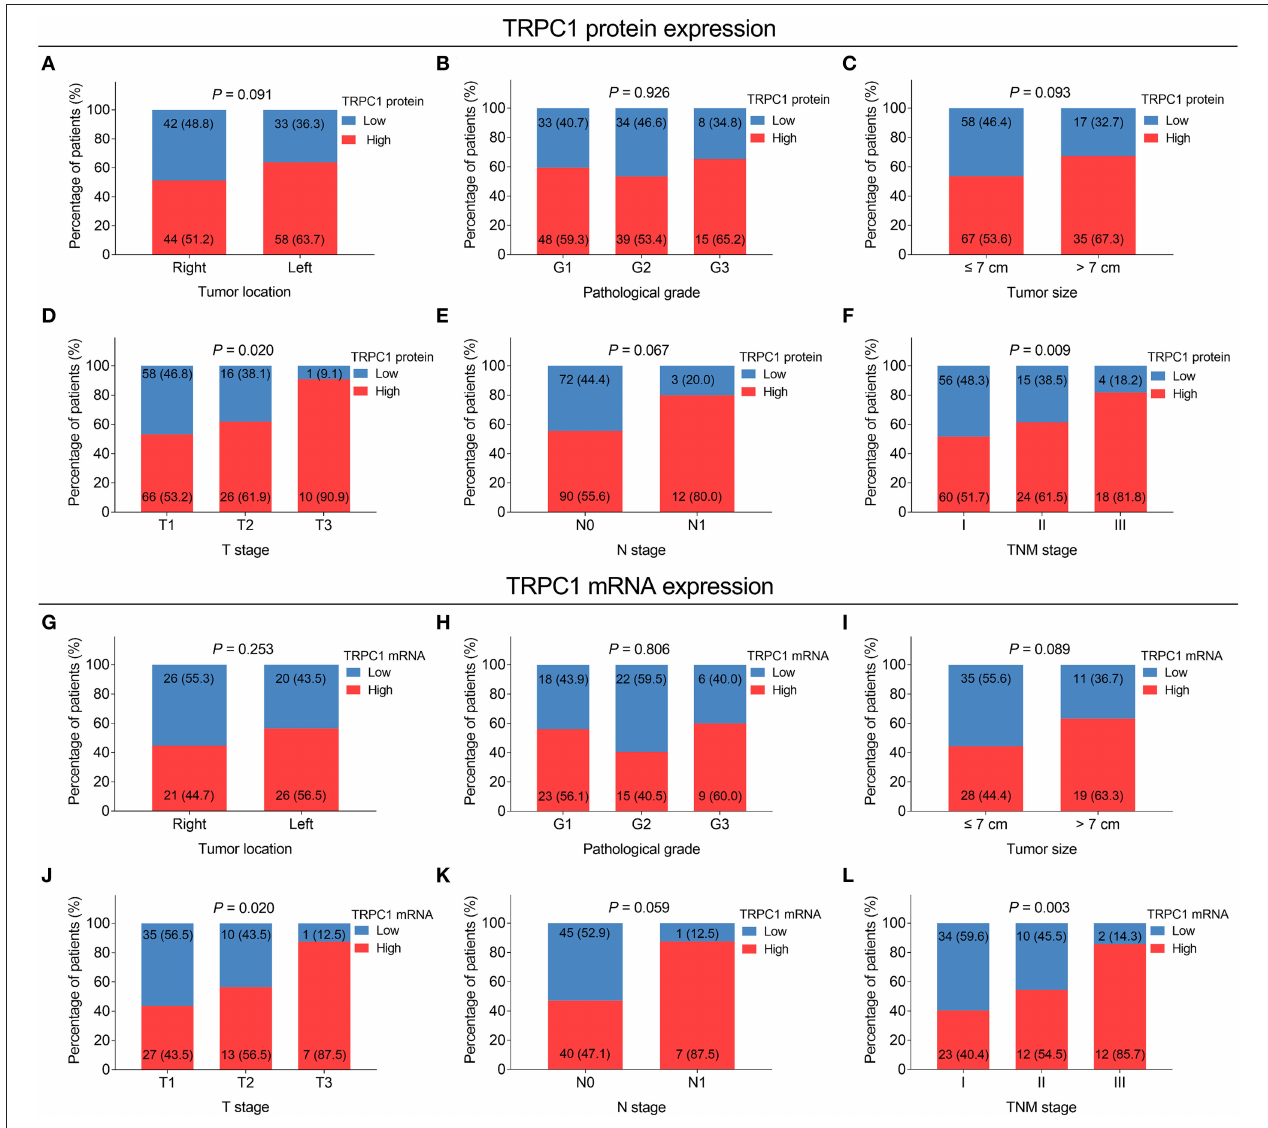
FIGURE 2 | Correlation of TRPC1 expression with tumor features in patients with RCC. Correlation of TRPC1 protein expression with tumor location (A) , pathological grade (B) , tumor size (C) , T stage (D) , N stage (E) , and tumor-node-metastasis (TNM) stage (F) ; association of TRPC1 mRNA expression with tumor location (G) , pathological grade (H) , tumor size (I) , T stage (J) , N stage (K) , and TNM stage (L) . TRPC1, transient receptor potential channel 1; TNM, tumor-node-metastasis; mRNA, messenger RNA; RCC, renal cell